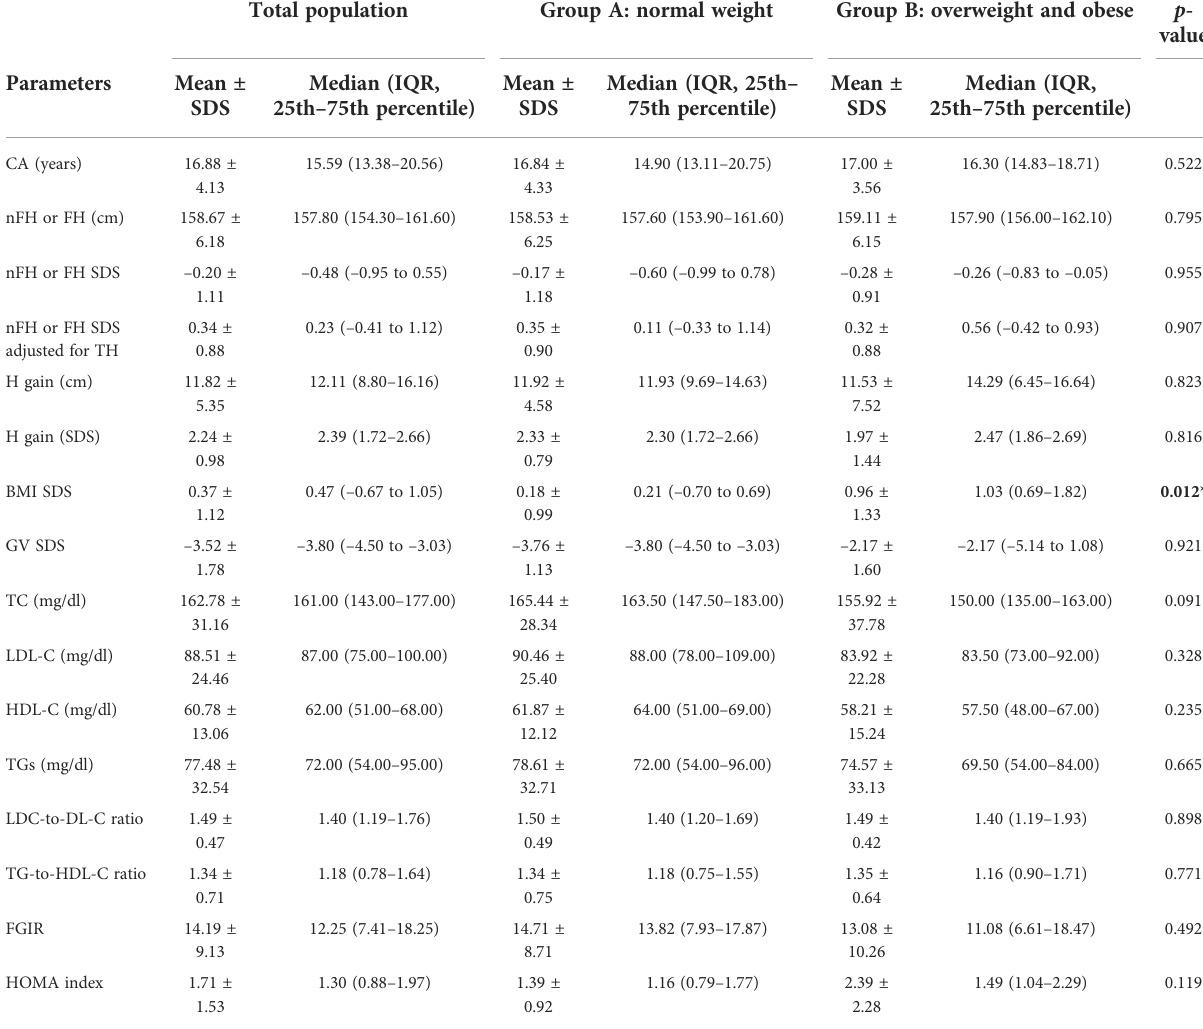
TABLE 3 Anthropometric and biochemical features in total population, groups A and B at the achievement of near- fi nal height (nFH) or fi nal height (FH) (T3). Total population Group A: normal weight Group B: overweight and obese p -